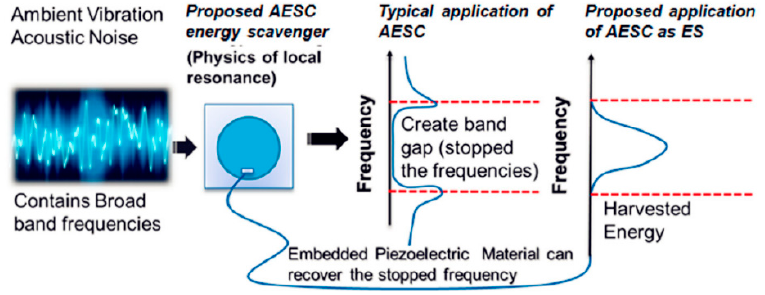
Figure 23. Proposed sonic-crystal structure for noise filtering and energy harvesting. Reproduced with permission from [66]; published by SAGE journals, 2017.